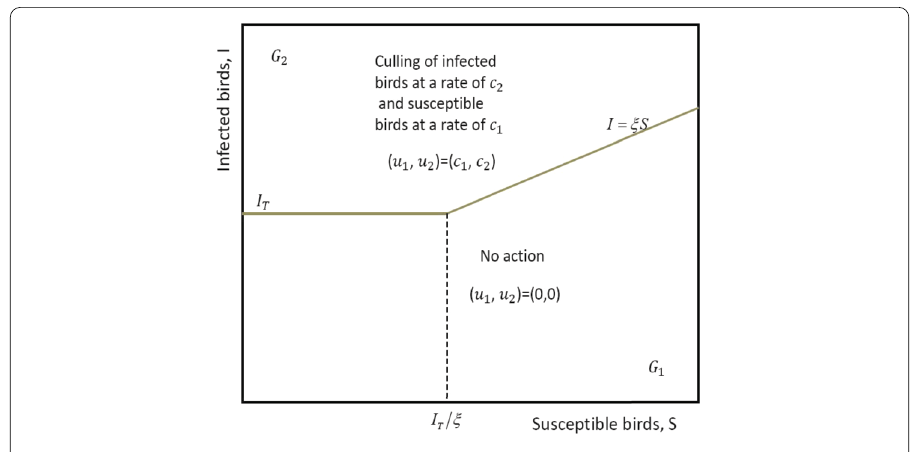
Figure 1 Schematic diagram of the threshold